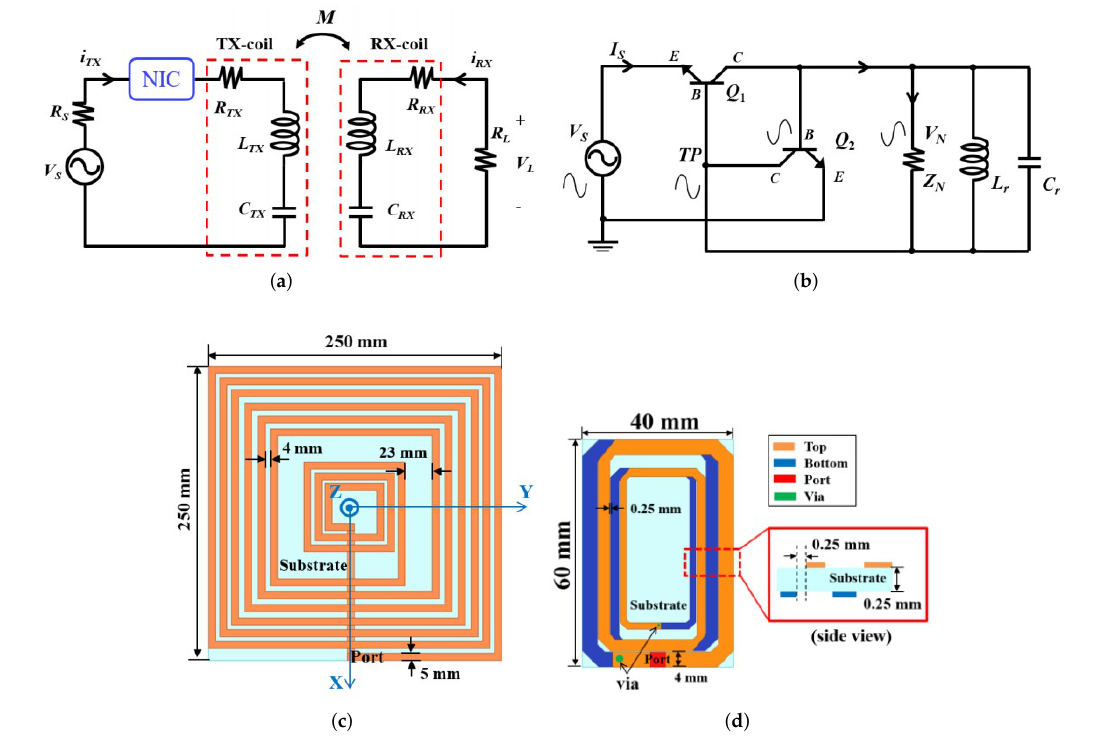
Figure 32. ( a ) proposed WPT system with the use of NIC, ( b ) the circuit-level of NIC, ( c ) TX-coil, ( d ) Rx-coil presented in [64]. Table 2. Take-home messages of the WPT systems studied for biomedical applications presented in Section